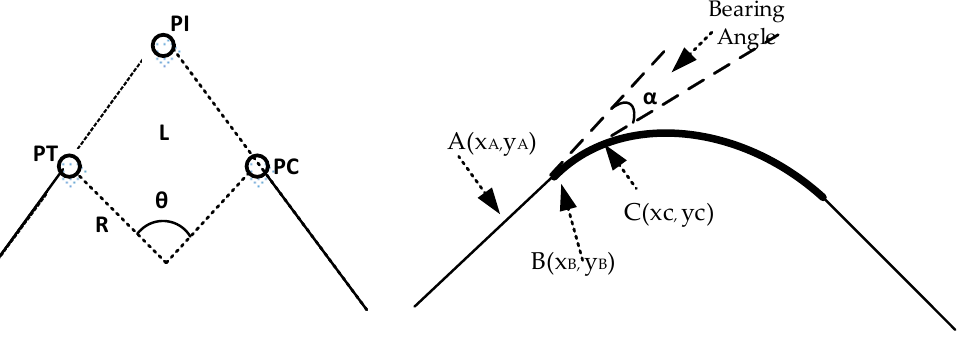
Figure 5. Representations of curvature parameters.